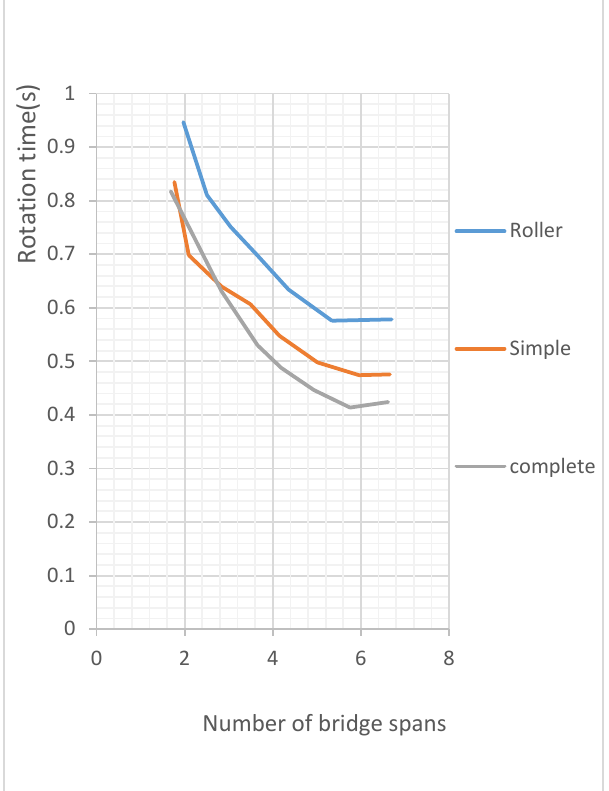
Fig. 12. The fundamental period of longitudinal vibration in bridges with a base height of 6